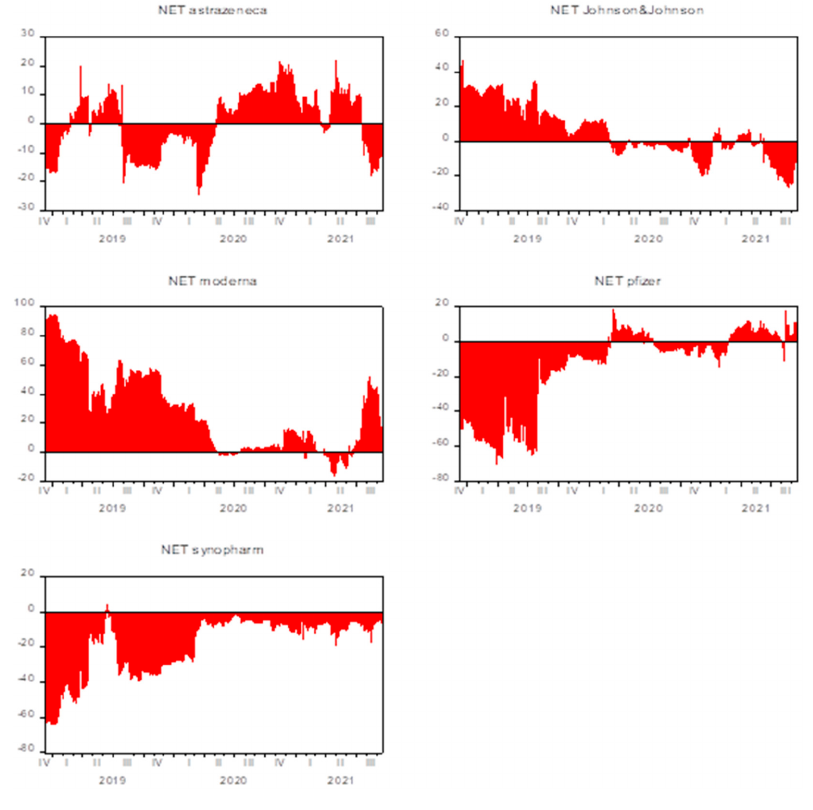
Figure 3. Net volatility spillovers.